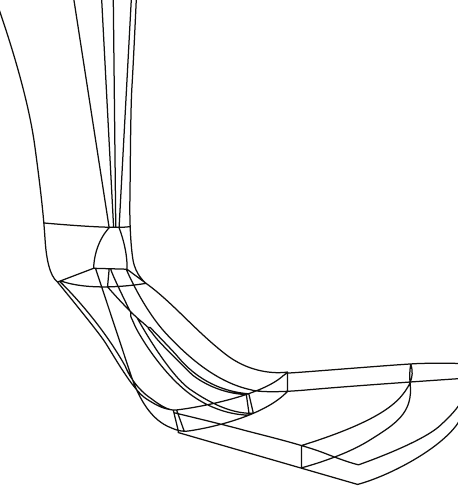
Figure 2: The computational domain.